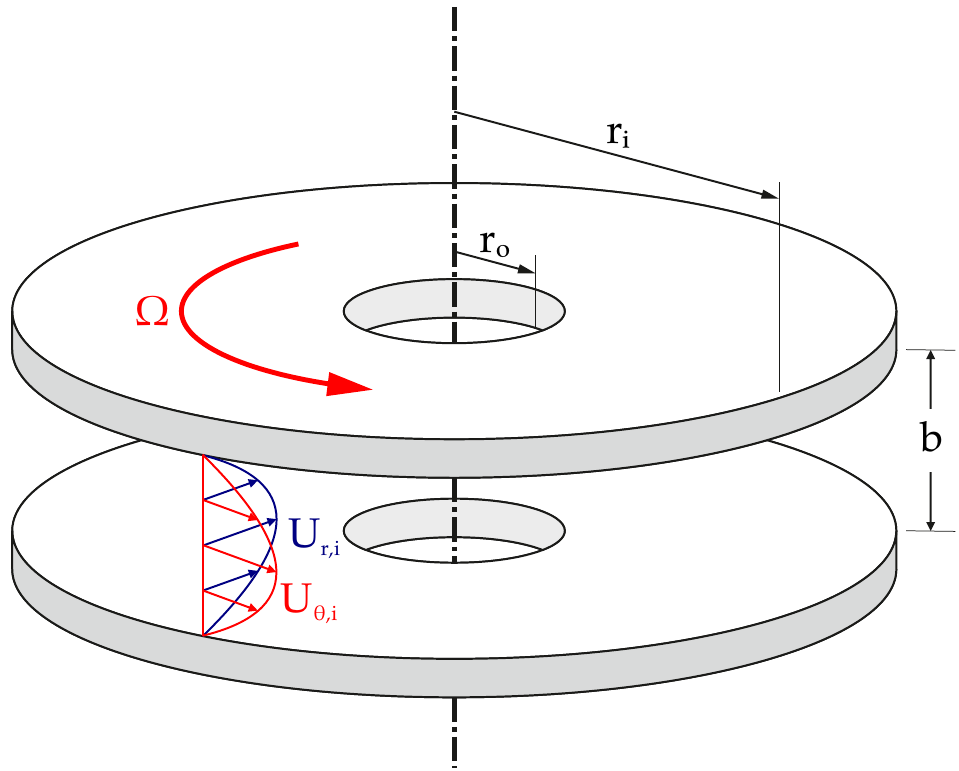
Figure 1. Analytical model for the fluid flow of a Tesla turbine design. The flow enters at radius r i and exits the central outlet at r o . The gap is given by b . Ω is the rotational speed of the disc and the absolute velocity of the fluid is given by U , with the subscript of θ reflecting the azimuthal direction in cylindrical coordinate